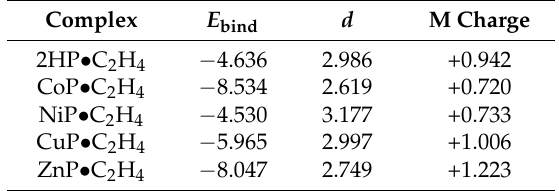
Figure 11. Porphyrin•C 2 H 4 model ( MP •C 2 H 4 ) used to understand the nature of the interaction between the porphyrin host 8 and the fullerene derivative guest 7 . Except for the ethylene carbon atoms depicted in red, the following color code is used: carbon in green, nitrogen in blue and hydrogen in white. Table 4. Binding energy (kcal/mol), metal–ethylene distance d (Å), and natural population analysis (NPA) charge of the porphyrin central atom (M = 2H. Co., Ni, Cu, Zn) calculated at the PBE0-D3/cc-pVTZ level of theory for the simplified porphyrin–ethylene associates [92].